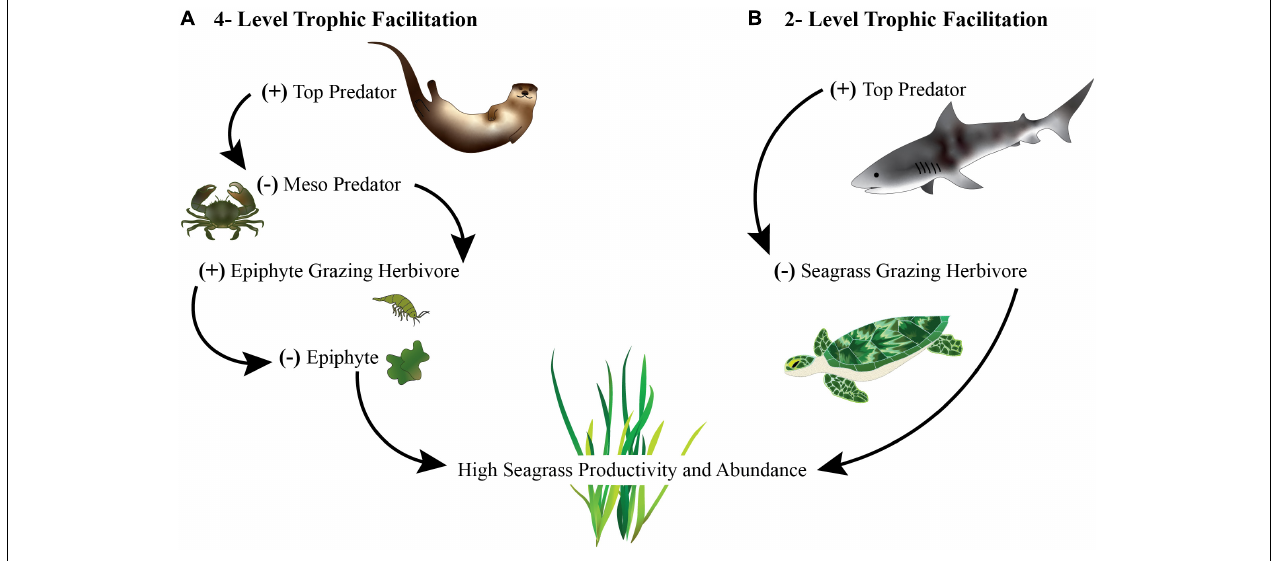
FIGURE 3 | Illustration depicting trophic facilitations where: (A) indirect consumption by top predators (sea otters) creates a cascade effect reducing mesopredators (crabs), increasing mesograzers (herbivorous invertebrates) that remove harmful epiphytes on seagrass that result in increased seagrass or (B) direct consumption or removal of seagrass eating herbivores (turtles) by top predators (sharks) maintains seagrass.